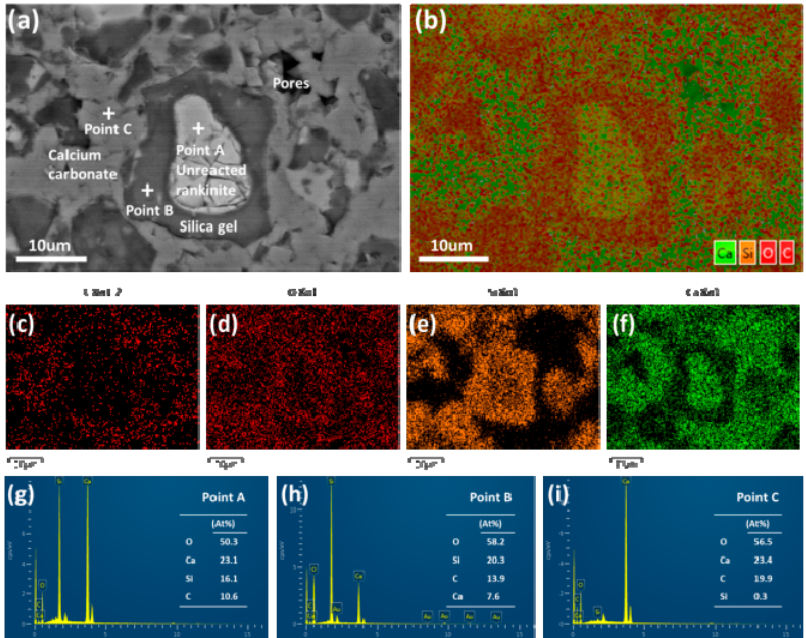
Figure 6. SEM and EDS images of the compacted C 3 S 2 samples carbonated for 24 h: ( a ) BSE image, ( b – f ) elemental maps for composite elements and C, O, Si, Ca, respectively, ( g – i ) EDS analysis of point A, B and C.